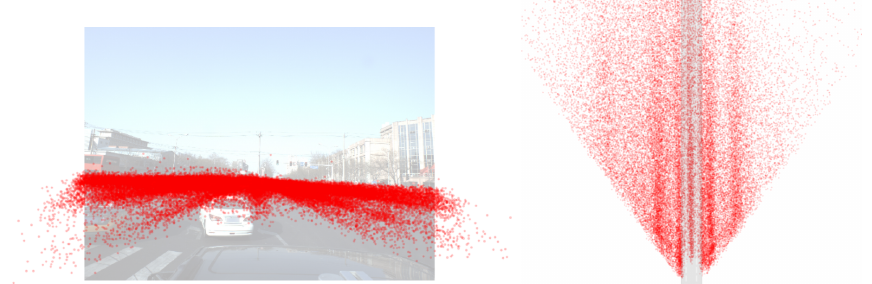
Figure 4. Vehicle object distribution in the dataset from the camera’s view ( left ) and viewed from the sky ( right